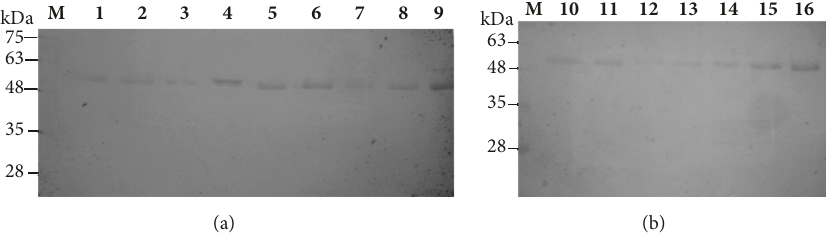
Figure 3: Western blot analysis of protein expression using IL-6 antibody. Proteins were analysed on 10% w/v SDS-polyacrylamide gels. M: prestained protein markers, lanes 1-9 (a) and 10 -16 (b): 50 𝜇 g total